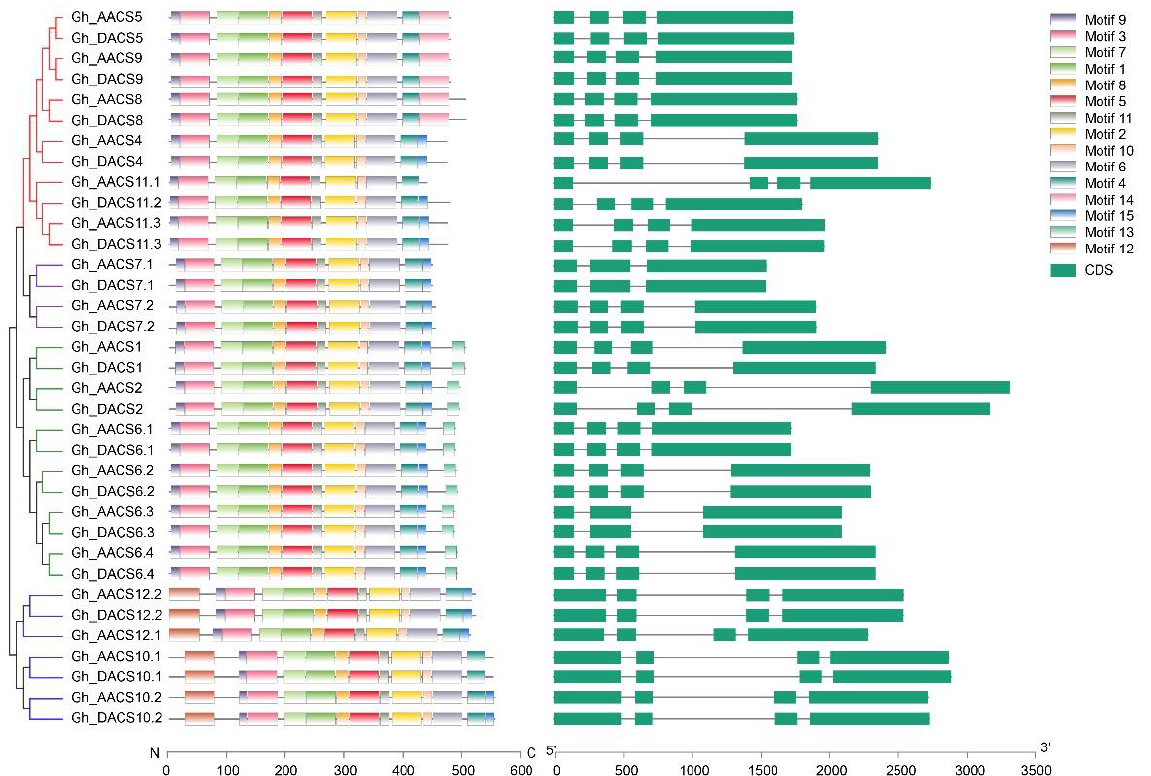
Figure 4. Conserved motifs in the GhACS proteins and exon – intron structure of the GhACS genes.